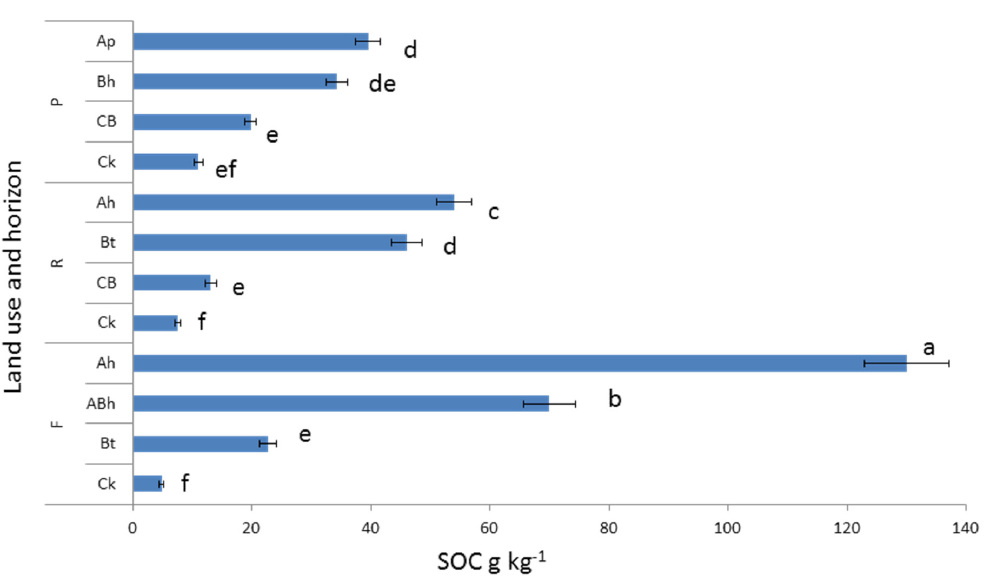
Figure 3. Soil organic carbon concentration according to the land use (forest, F; reforestation, R; prairie, P) per soil depth interaction. Data followed by the same letter are not statistically different from each other (Student’s test, p = 0.05).